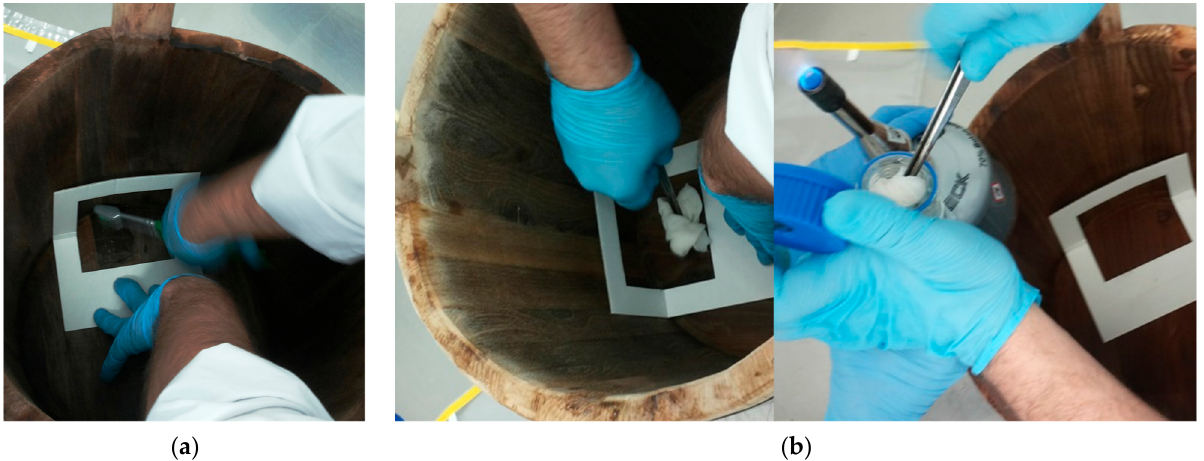
Figure 5. Wooden vat biofilm collection: ( a ) Brushing; ( b ) collection by gauze.